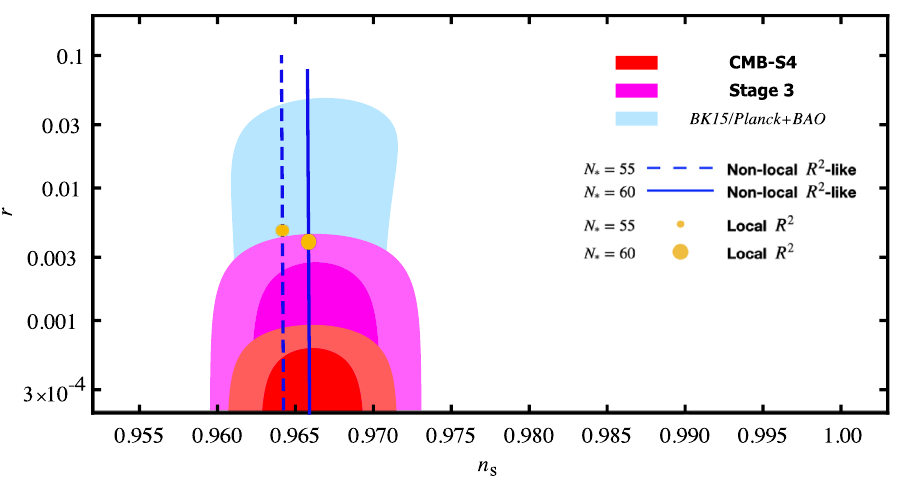
Figure 4 . In the above plot, we depict the predictions of non-local R 2 -like in(cid:13)ation in the ( n s ; r ) plane of the latest CMB S-4 science paper about future forecast of detecting B -modes